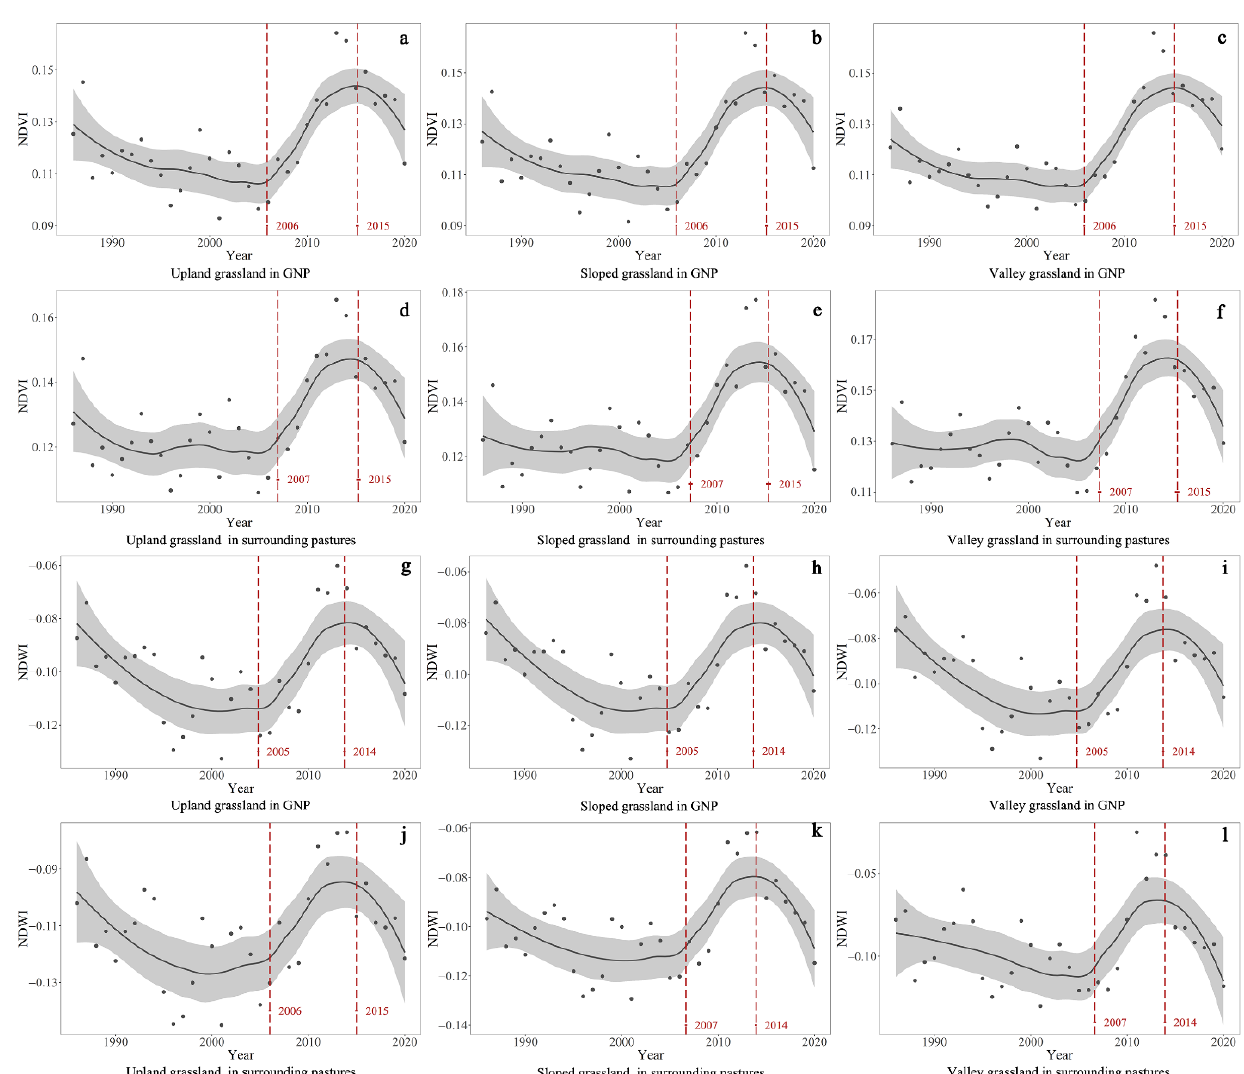
Figure 5. The temporal trends of normalized difference vegetation index (NDVI) and normalized difference water index (NDWI): ( a – c ) are the temporal trends of NDVI for upland, sloped, and valley grasslands in Grasslands National Park (GNP), respectively; ( d – f ) are the temporal trends of NDVI for upland, sloped and valley grasslands in the surrounding pastures, respectively; ( g – i ) are the temporal trends of NDWI for upland, sloped, and valley grasslands in GNP, respectively; ( j – l ) is the temporal trend of NDWI for upland, sloped and valley grasslands in the surrounding pastures, respectively.